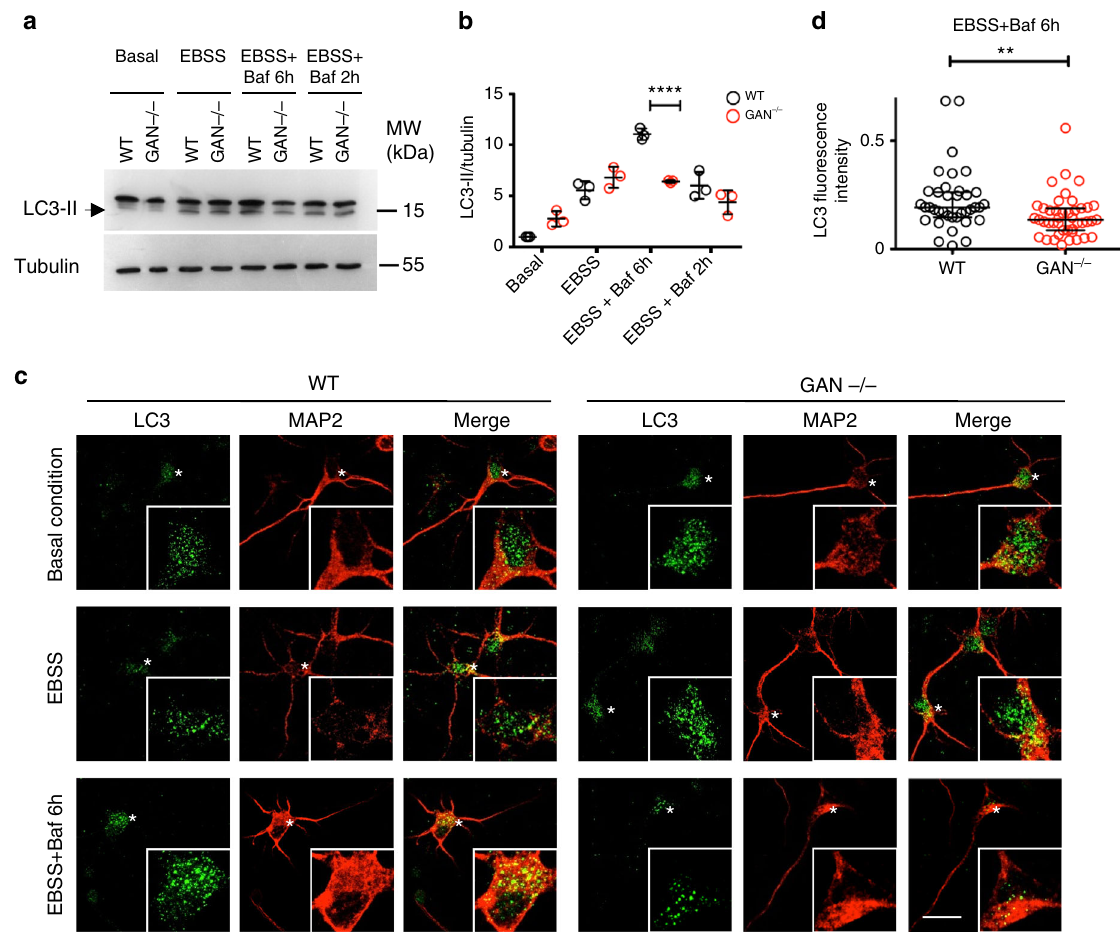
Fig. 5 Gigaxonin depletion causes a defect in autophagosome production. a – d Wild-type and GAN -/- cortical neurons were cultured for 4 div under basal condition, or with different treatments to evaluate autophagy activity. Starvation was induced with EBSS, autophagosome-lysosome fusion was